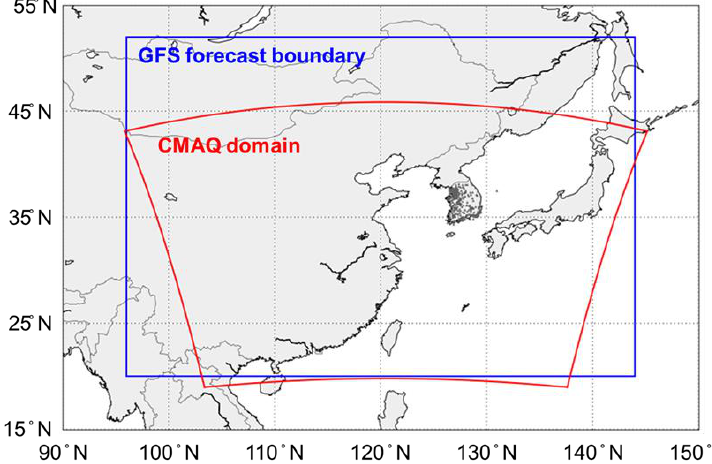
Figure 3. Boundary of the CMAQ prediction (red line) and GFS forecast (blue line). The grey triangles and dots represent the locational information of ground monitoring stations in South Ko- rea.